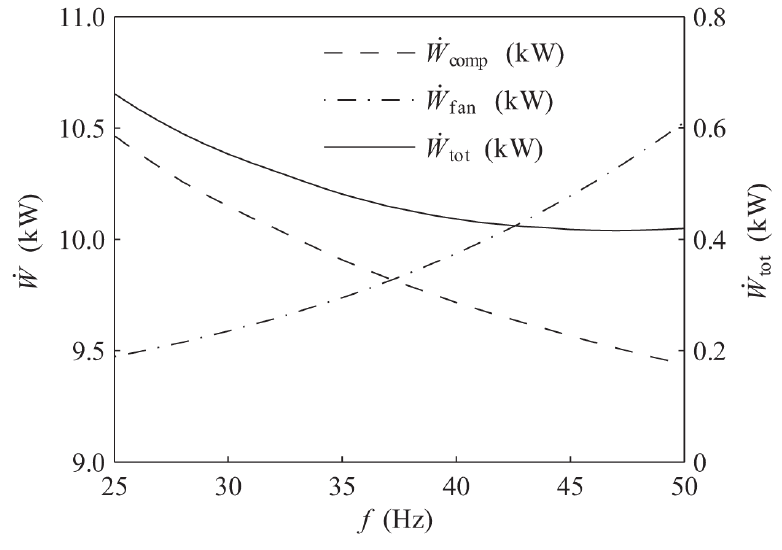
Figure 11. Interaction between the power consumption of the cooling tower fan and chiller